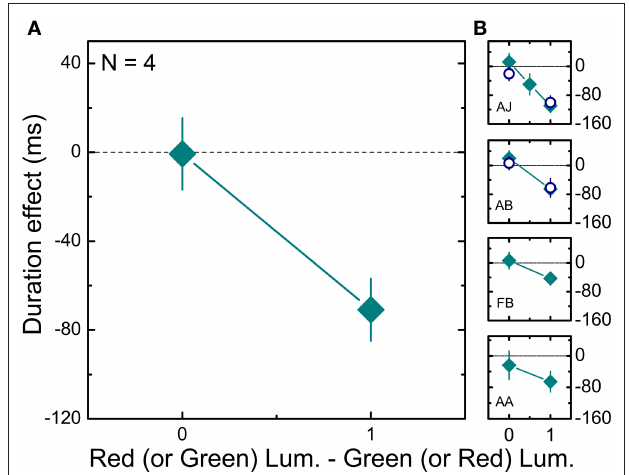
Figure 4 | effects of chromatic contrast on duration judgments. (A) Mean differences (averaged across four subjects) between the estimated duration (PSE) of a 50% chromatic contrast interval when preceded by a high (90%) chromatic contrast interval and when preceded by a low (10%) chromatic contrast interval are plotted as a function of the difference between the amplitude of red and green luminance gratings (0 on the x axis corresponds to isoluminance). Error bars show ± 1 SEM. (B) Individual results for four different subjects. Filled squares describe the results obtained when the minimum contrast level was 10%, while empty circles describe the results obtained when the minimum contrast level was 20%. Error bars show ± 1